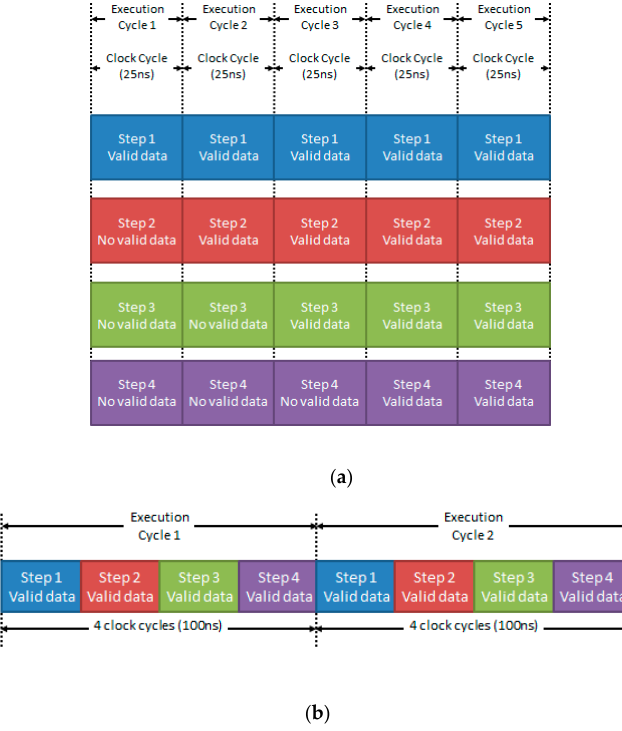
Figure 9. Execution diagram of the buck converter discrete model ( a ) using a pipeline and ( b ) without a pipeline.